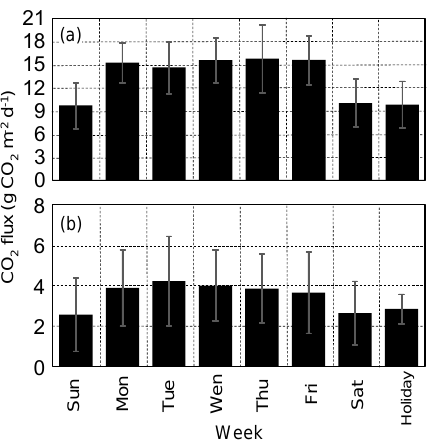
Figure 8. Averaged daily CO 2 flux for each day of the week in 2015 for (a) SAC west and (b) OPU; fluxes for holidays were averaged separately. Vertical lines represent standard deviation.